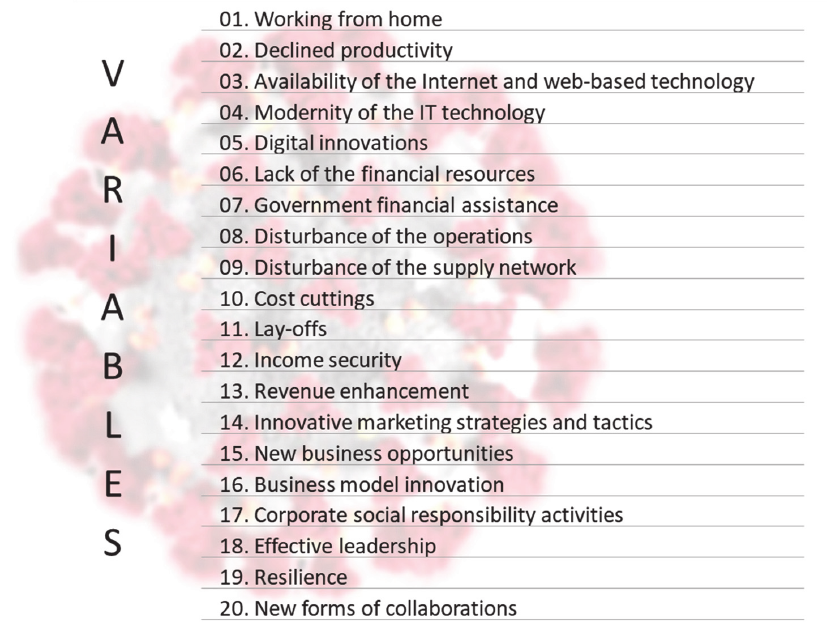
Fig. 1. Variables generated from the literature for the research scale “Impact of COVID-19 on